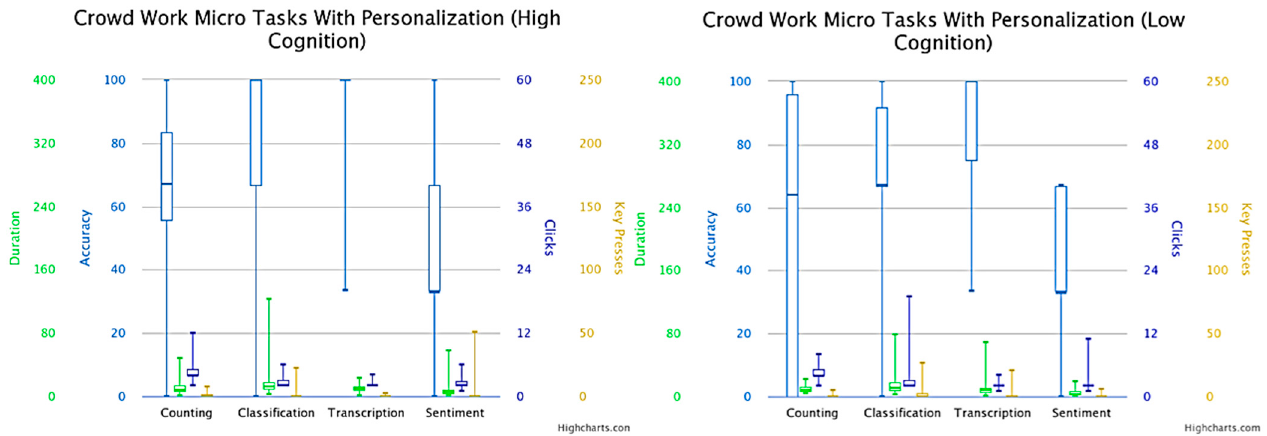
Figure 2. Box plot of microtask accuracy with personalization (easier difficulty) for crowd workers with a cognitive ability score equal or above median ( left )/below median ( right ).